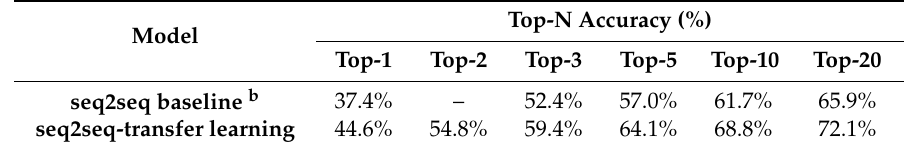
Table 2. Comparison of the top-N accuracies a of the seq2seq and seq2seq-transfer learning models.